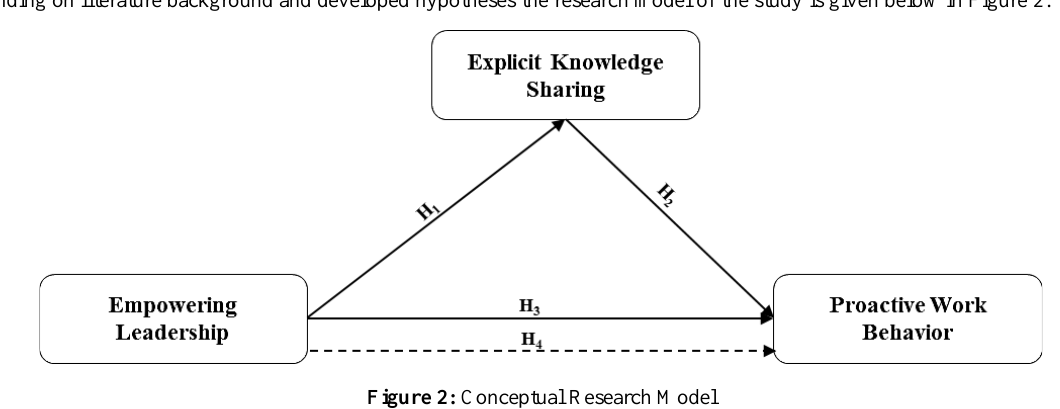
Figure 2: Conceptual Research